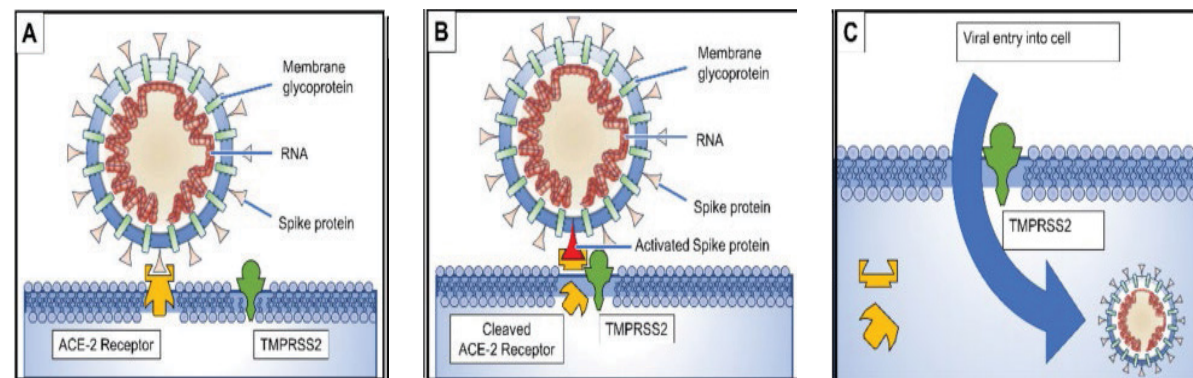
Figure 1: Three-step SARS-Cov-2 virus internalization in a host cell; Source: Rabi FA et al. Pathogens 2020 6